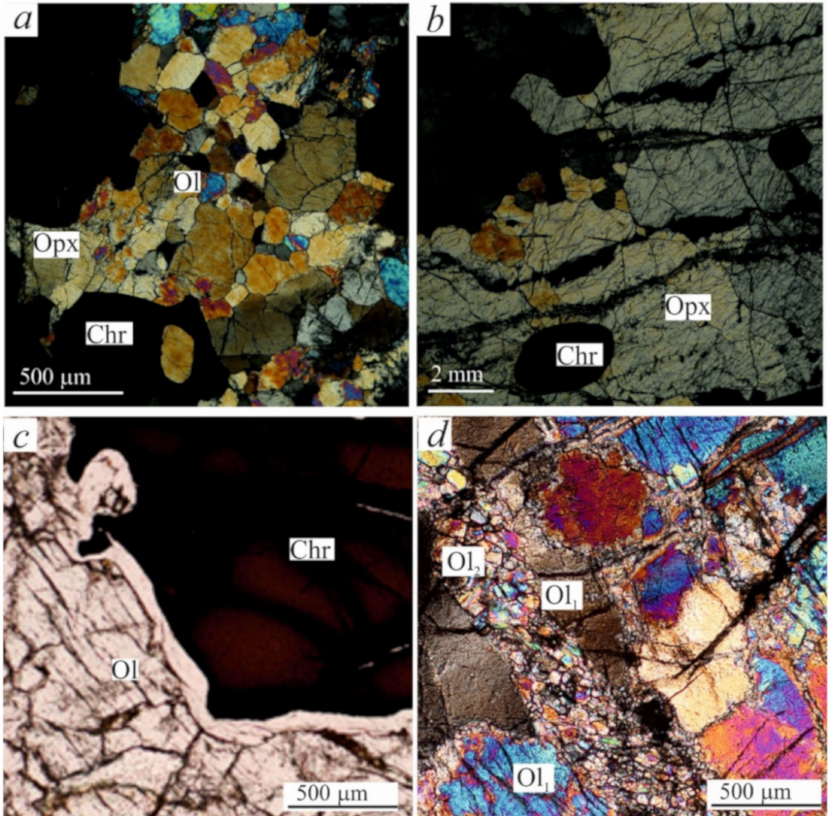
Figure 5. Optical photomicrographs of mantle peridotite in cross- and plane-polarized light: ( a ) Harzburgite with dessimination Cr-spinel (Chr)–granoblastic textures; ( b ) harzburgite with the Cr-spinel inclusions in orthopyroxene (Opx); ( c ) subeuhedral grain of Cr-spinel in the dunite; and ( d